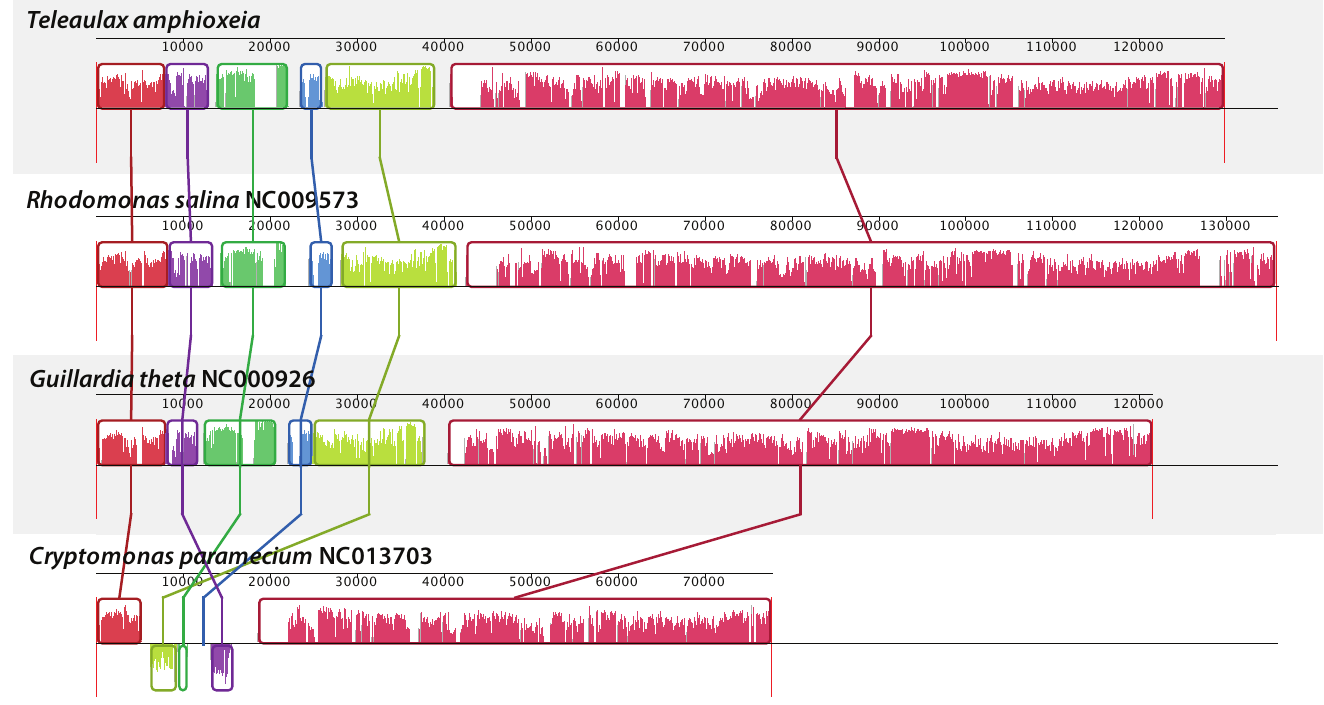
Fig 2. Overview of the red algal plastid genomes. Linearized maps of the complete T . amphioxeia plastid genome is compared with those of other cryptophytes. Color-coded syntenic blocks are shown above each genome, and gene maps are shown below each genome. The syntenic blocks above the horizontal line are on the same strand, and those below the line are on the opposite strand. The horizontal bars inside of the syntenic blocks indicate sequence conservation. The block boundaries correspond to sites at which inversion events occurred. On the gene maps, the genes above the horizontal line are transcribed from left to right, and those below the horizontal line are transcribed from right to left. The rRNA operons are shown in red.